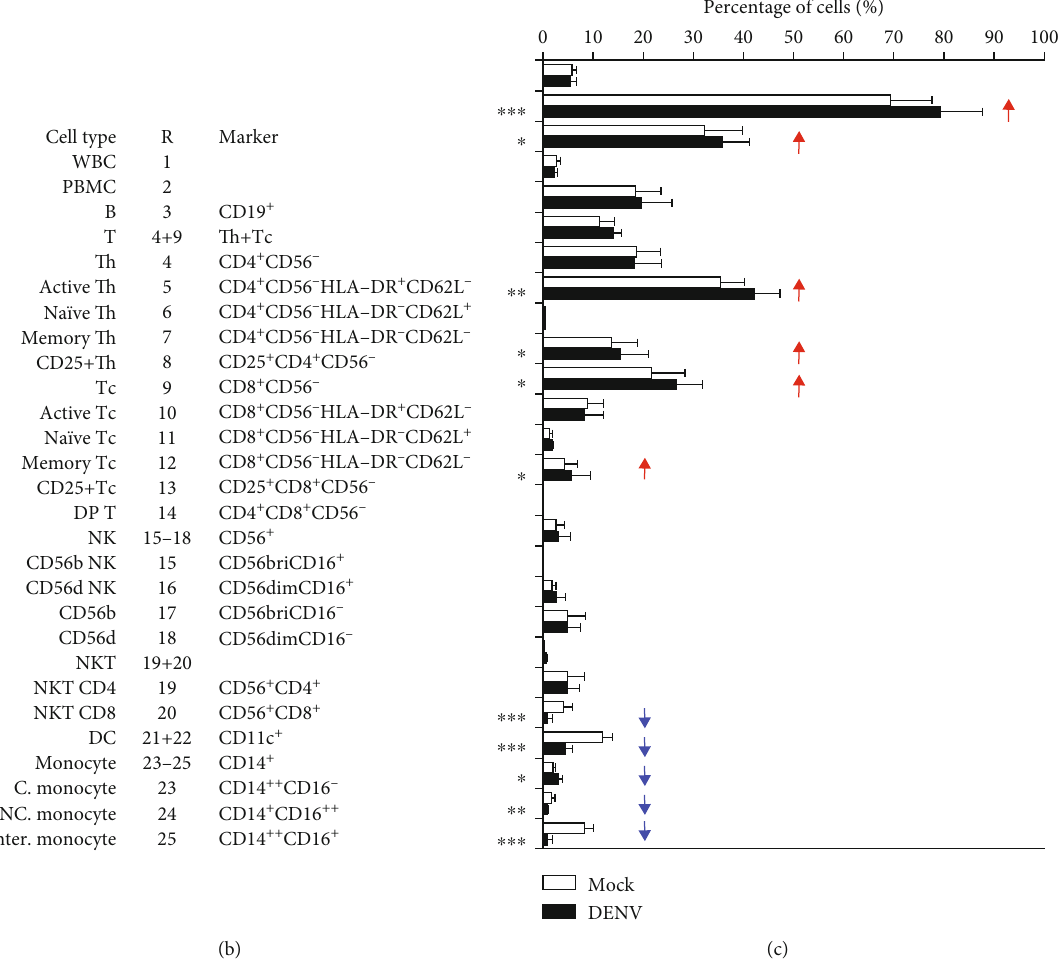
Figure 4: Immune pro fi ling in DENV-treated whole blood cells 24 h postincubation. Following DENV ( MOI = 1 ) coculture in 100 μ l of WB ex vivo for 24 h, (a) representative fl ow cytometric analysis and gating of various cells obtained from fi ve cases, performed by staining for speci fi c cell surface markers (CD4, CD8, CD11c, CD14, CD16, CD19, CD25, CD56, CD62L, and HLA-DR), in the DENV-infected and mock groups showed (b) the changes in the expression of speci fi c immune cell populations as noted. (c) The results are shown as a percentage of the mean ± SD obtained from fi ve cases. ∗ p < 0 : 05 , ∗∗ p < 0 : 01 , and ∗∗∗ p < 0 : 001 , compared to the mock group. R: region; WBC: white blood cell; bri: